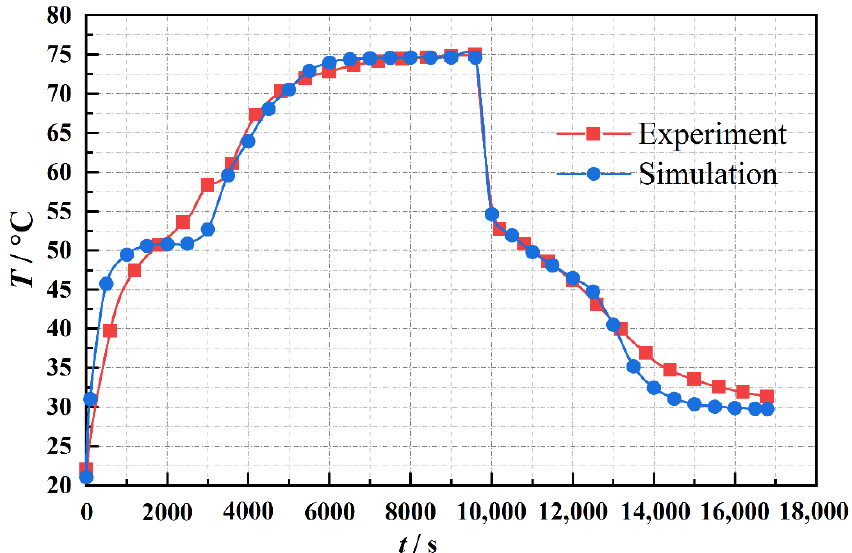
Figure 3. Simulation and experimental temperature validation.